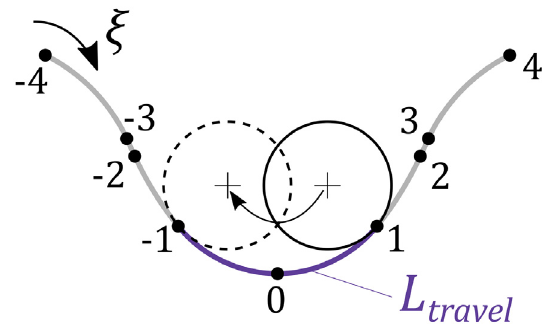
Fig. 19. De fi nition of j for ASA tooth pro fi le [18].